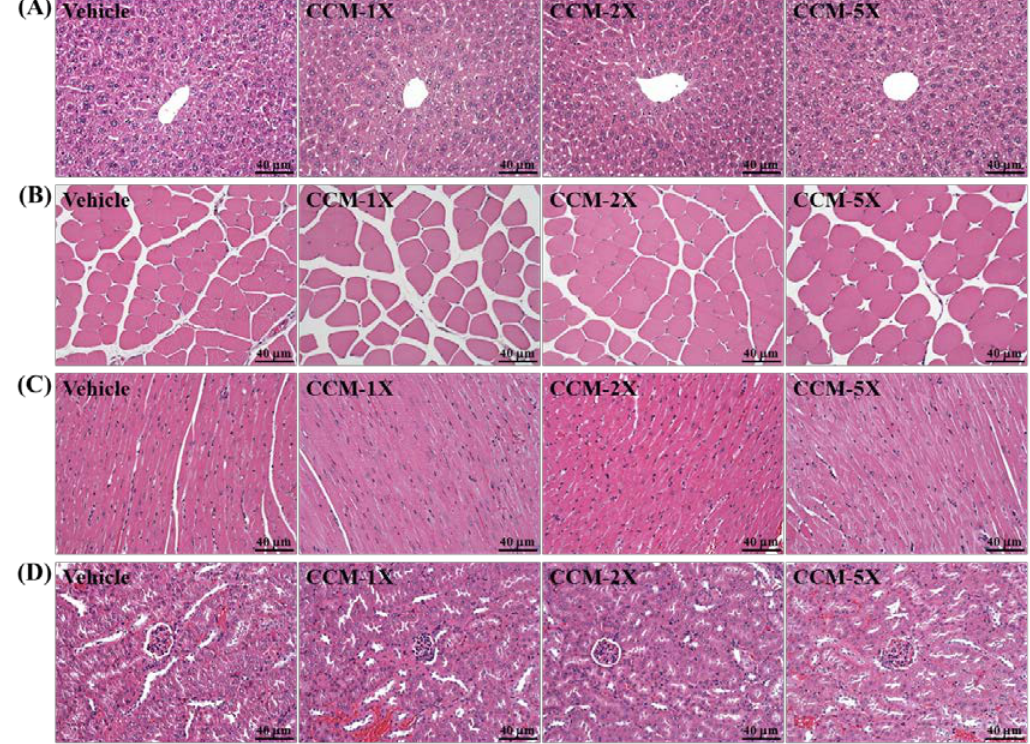
Figure 8. Effect of CCM supplementation on morphology of ( A ) liver; ( B ) skeletal muscle; ( C ) heart; and ( D ) kidney in mice. Specimens were photographed by light microscopy. (H&E stain, magnification: ×200; Scale bar, 10